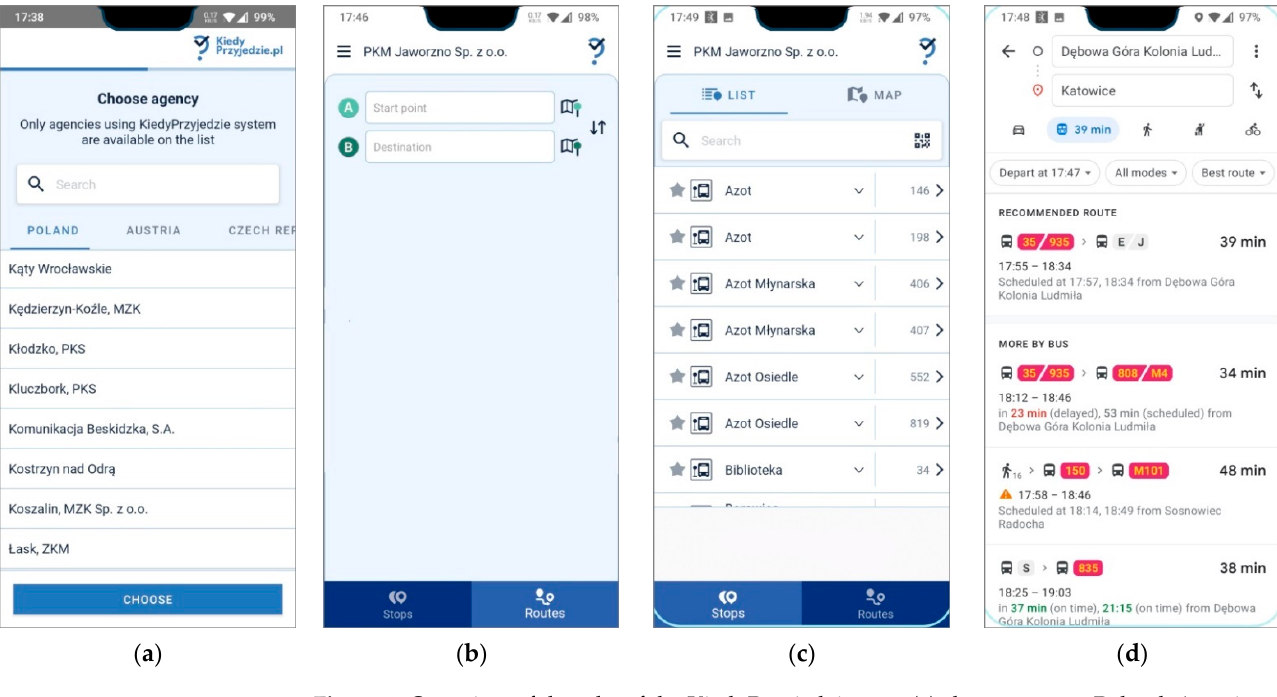
Figure 4. Overview of the tabs of the KiedyPrzyjedzie app: ( a ) choose agency Poland, Austria and Czech Republic; ( b ) selecting the starting point and destination; ( c ) selecting from a list of stops; ( d ) selecting route options on the Google Maps platform.